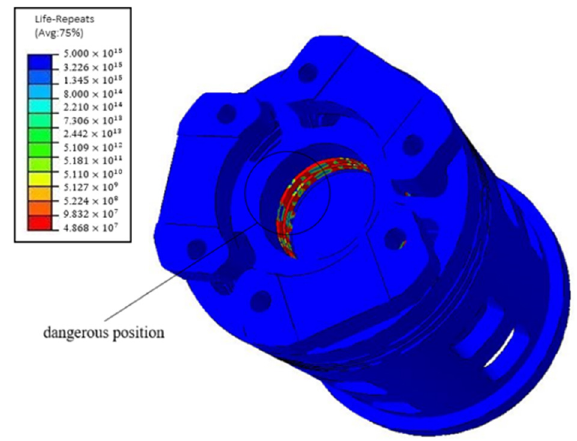
Figure 14. Fatigue life cloud picture.